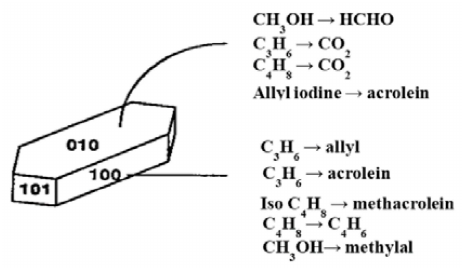
Figure 3. Structural sensitivity of selective oxidation reactions of olefins or methanol on single crystals of MoO 3 as plates (mainly (010) faces). Assignment of reactions to surfaces as indicated came from comparison of many sample shapes. Reproduced from [26]. Copyright 2015, Elsevier.